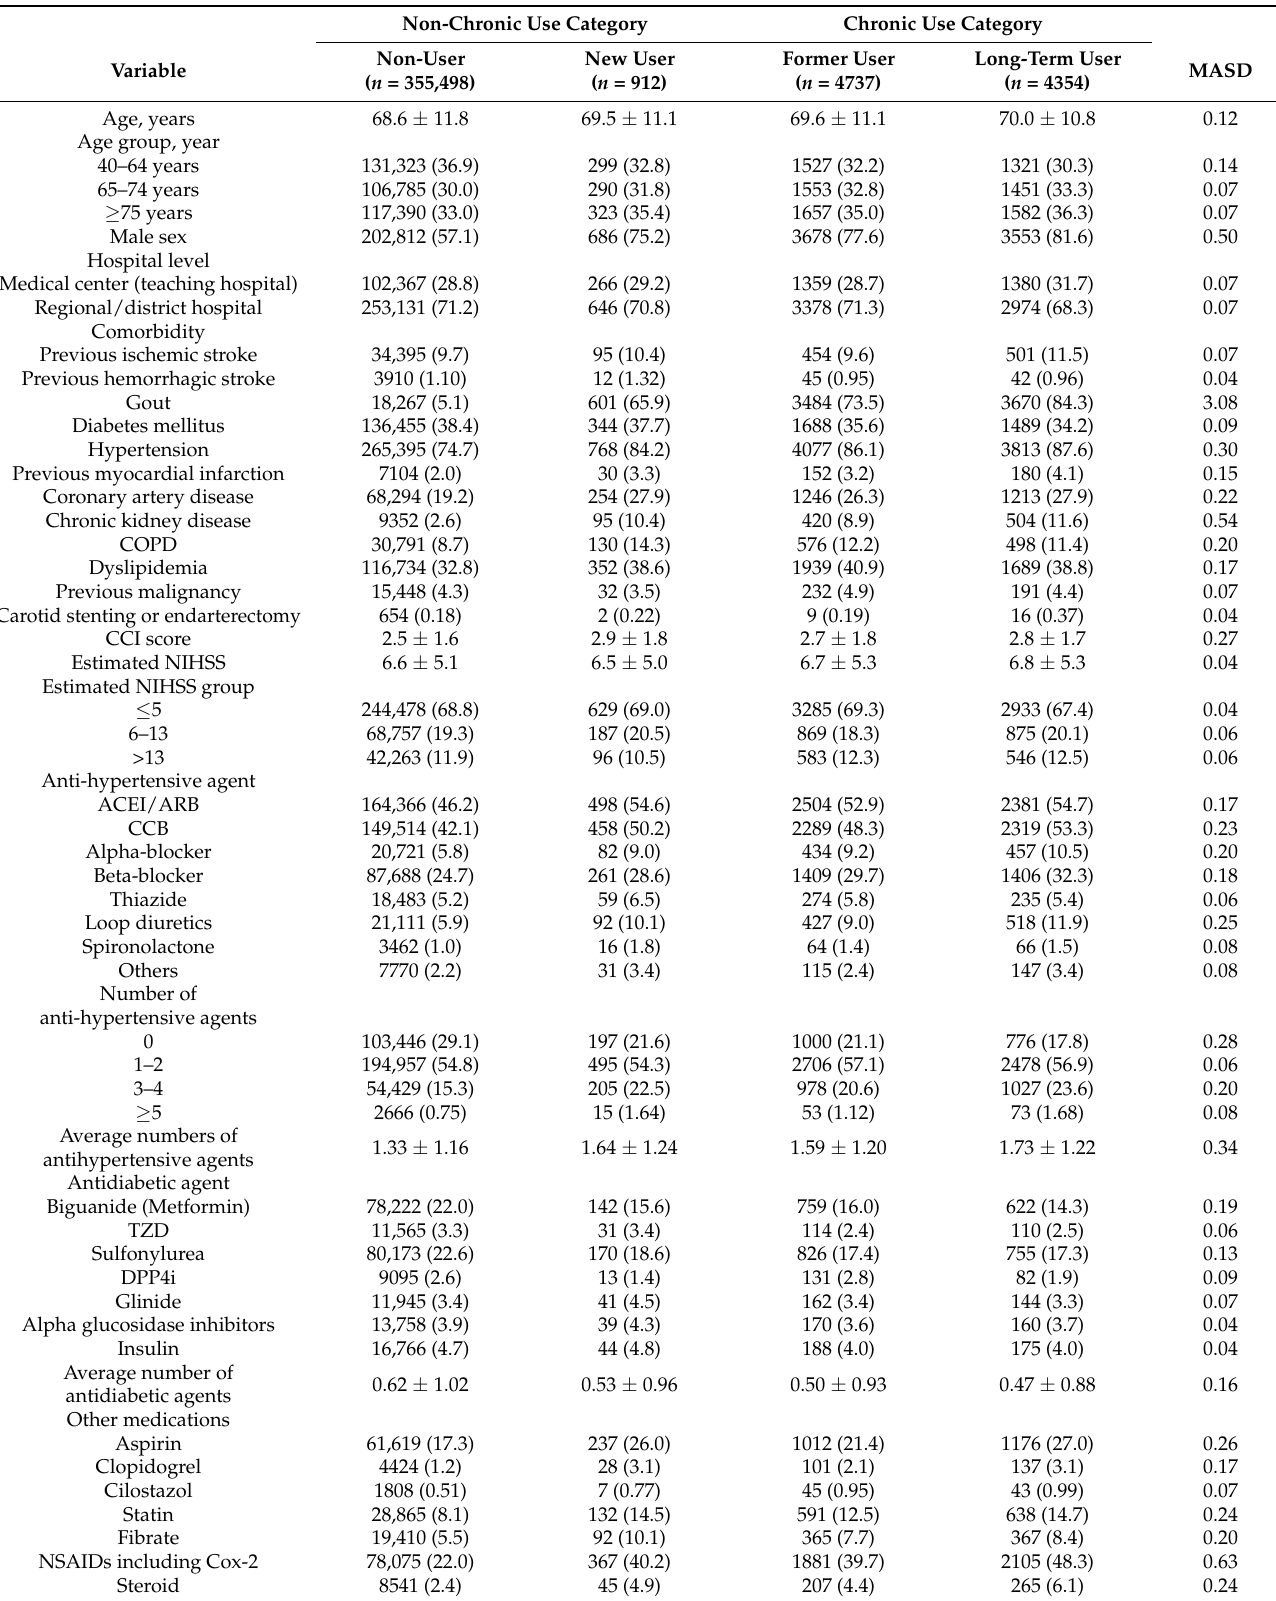
Table 1. Baseline characteristics of patients before